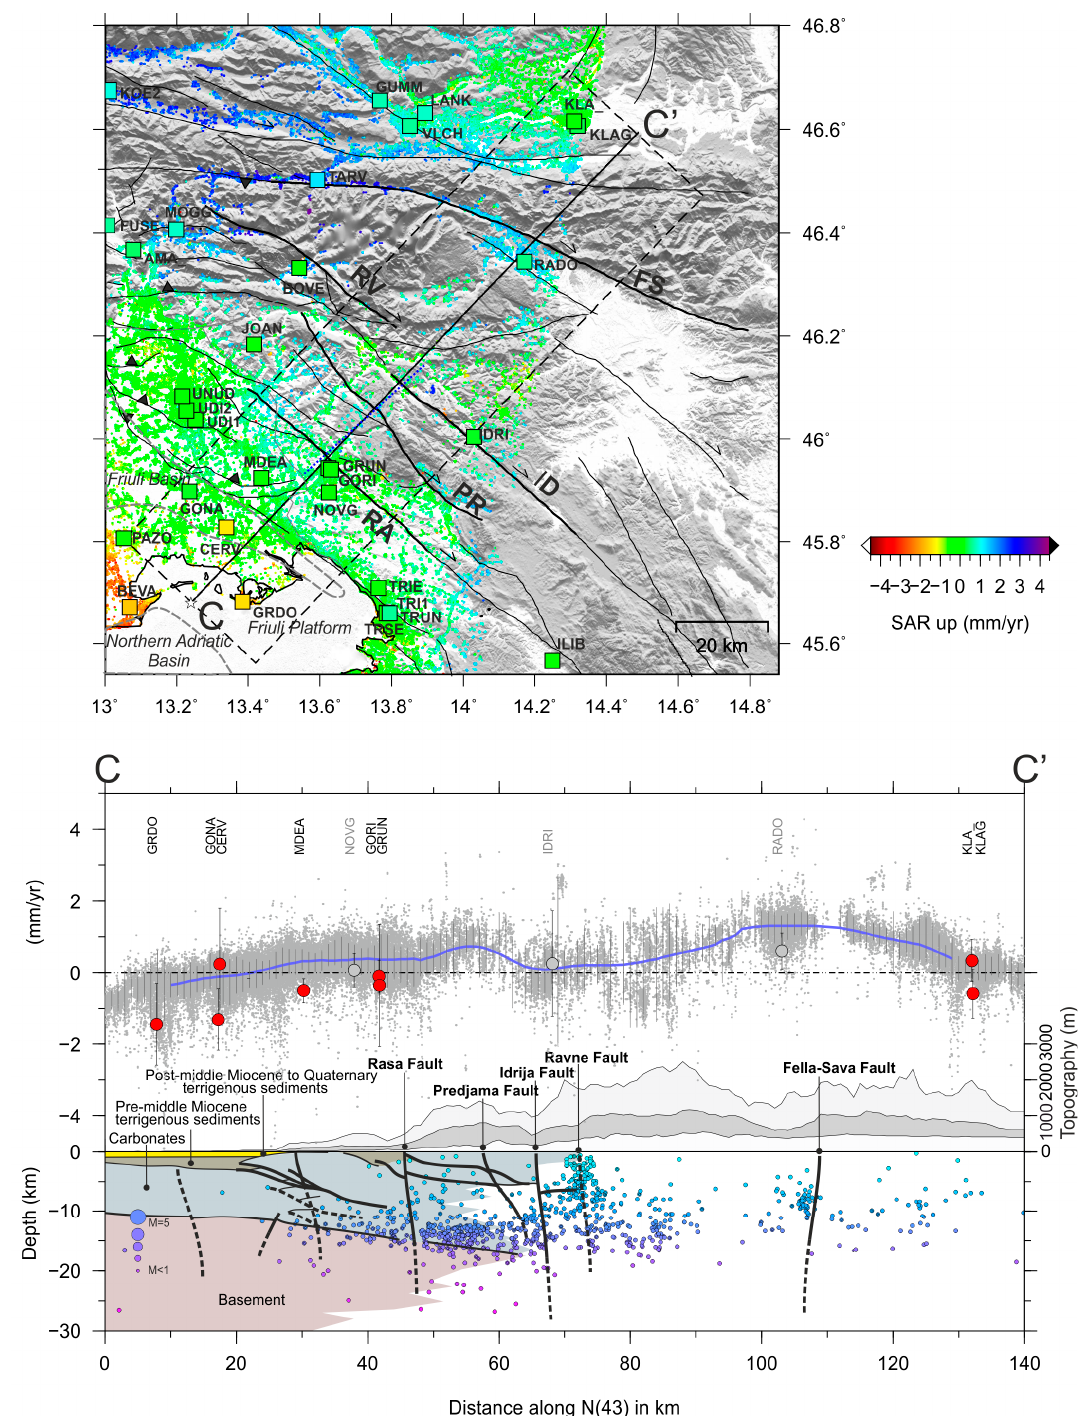
Figure 9. Vertical velocity profile across the Dinaric system. Top : the map shows the vertical velocity values for each PS, while the colored squares indicate the vertical velocity of the GNSS stations, according to the InSAR multicolor scale on the right (blue = uplift; red = subsidence). The blue dotted line represents the trace of the geological section reported below. The profile with a buffer of 20 km is 140 km long, and the white star indicates the starting point. Bottom : the plot shows the vertical InSAR velocities (grey dots), whereas the blue line indicates the median value. The circles with relative uncertainties represent the vertical velocities of GNSS stations; specifically, the grey ones have not been used during the calibration. The geological section is modified from Moulin et al. [56].